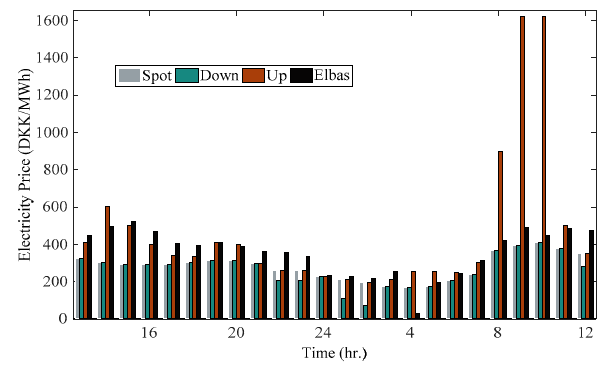
Figure 10. Day-ahead, balancing, and regulating prices.